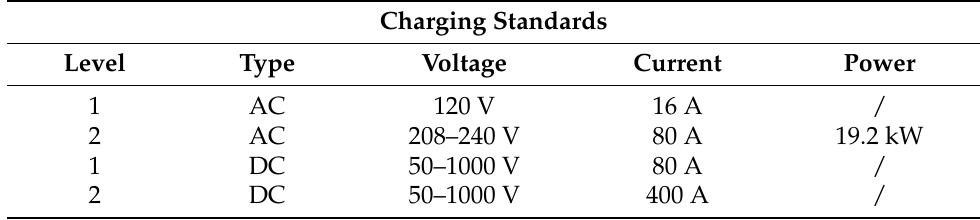
Table 2. Chargers standards.